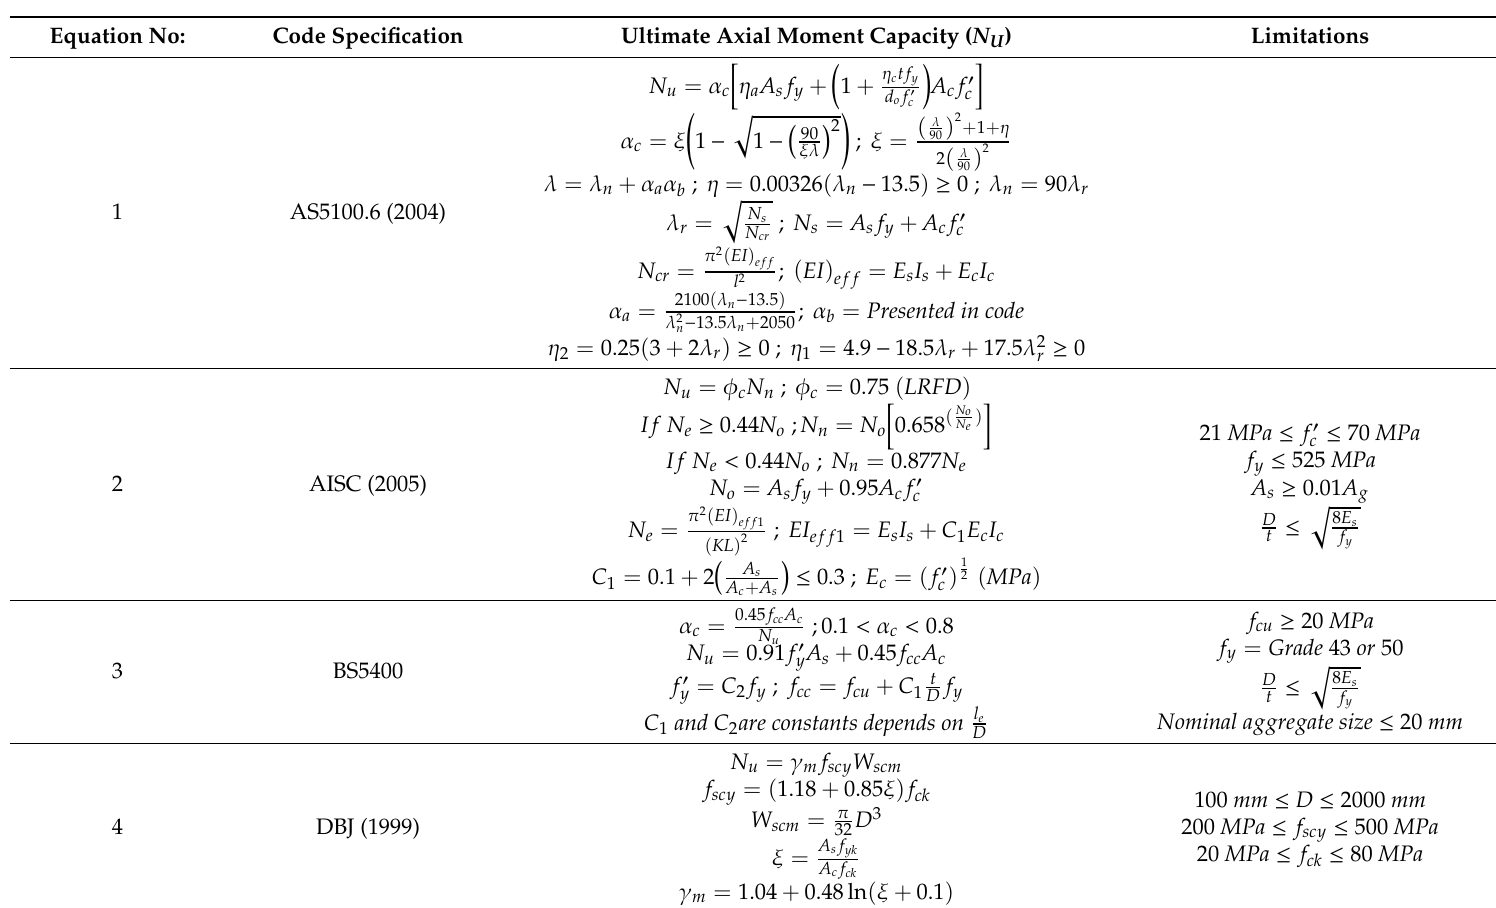
Table 5. Details of the